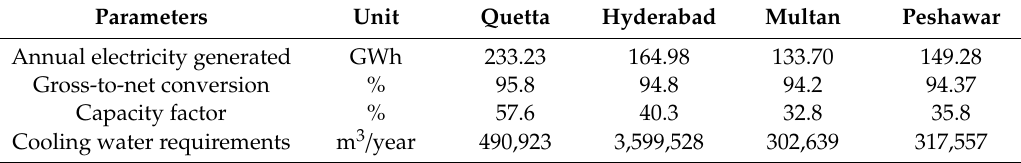
Figure 16. Electricity production by the 50 MWe SPT plant with evaporative cooling for different regions. Table 8. Performance parameters of the 50 MWe SPT plant with evaporative cooling.